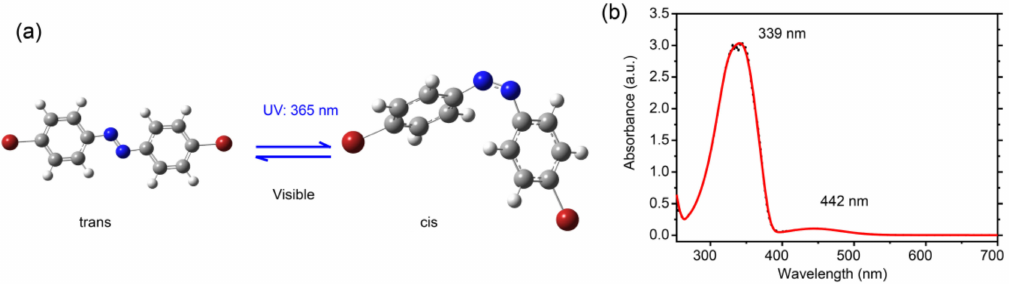
Figure 1. ( a ) Chemical structure of 4,4 (cid:48) -dibromo-azobenzene (Br-AB). Upon UV light exposure, the trans-isomer transforms into cis-isomer; and ( b ) Absorption spectra of the Br-AB molecular solution in